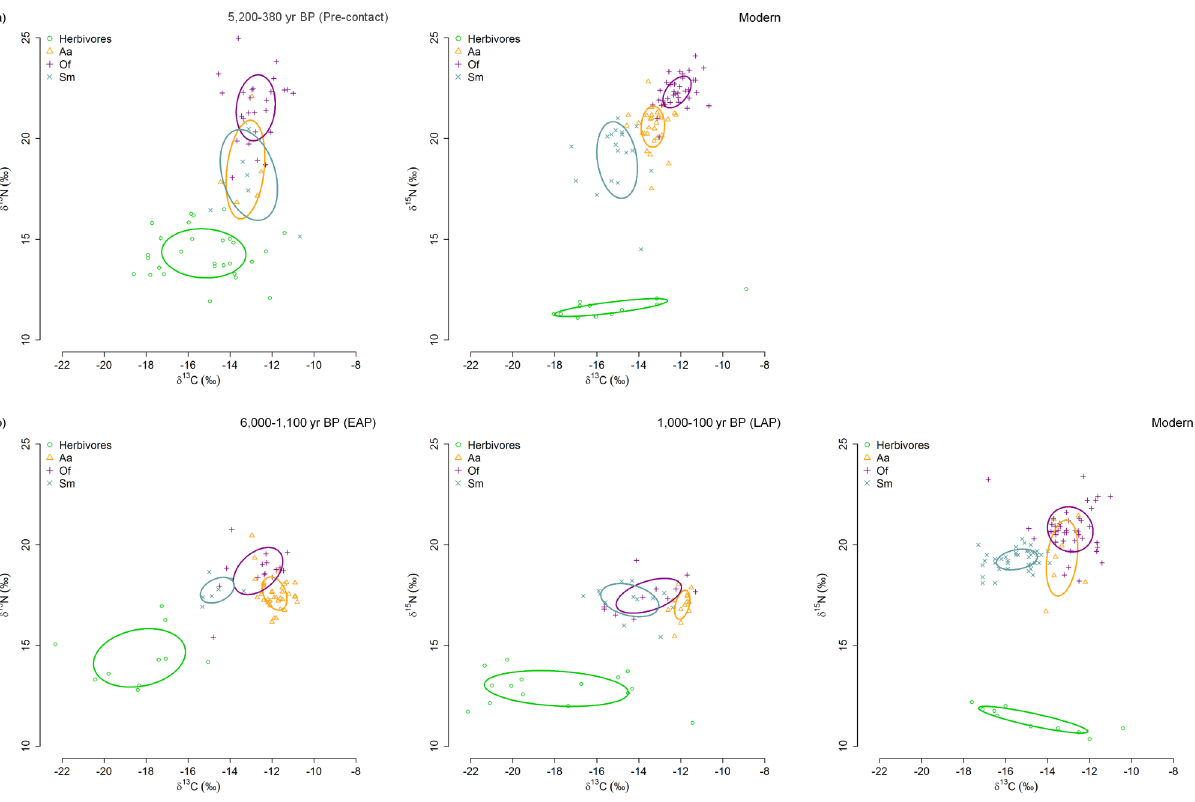
Figure 2. Isotopic niches/resource use areas of the species/functional groups described in the text and calculated with the standard ellipse areas corrected for small sample size (SEA C ) over time in the two geographical areas. a) Central-northern Patagonia and b) Southern Patagonia. Herbivores=mussels and limpets; Aa=South American fur seals; Of=South American sea lions; Sm=Magellanic penguins.